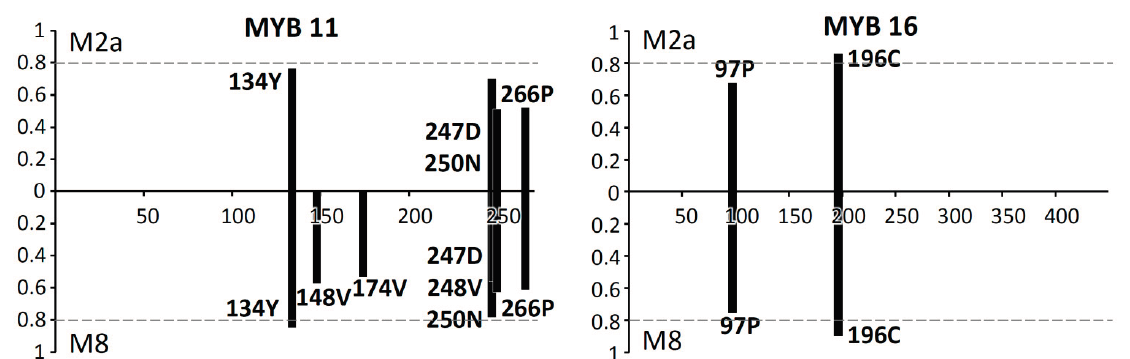
Figure 1. Neighbor-joining (NJ) tree of the R2R3-MYB paralogs expressed in the Scutellaria inflorescence buds and the corresponding sequences collected from GenBank. The NJ tree is reconstructed from realigned amino-acid sequences chosen from the preliminary NJ analyses (Figure S1). Amtri: Amborella trichopoda ; At: Arabidopsis thaliana ; Os: Oryza sativa ; Sbai: Scutellaria baicalensis ; Sind: Scutellaria indica ; Sly: Solanum lycopersicum ; Smon: Scutellaria montana ; Spla: Scutellaria playfairii ; Stai: Scutellaria taiwanensis ; Stas: Scutellaria tashiroi .